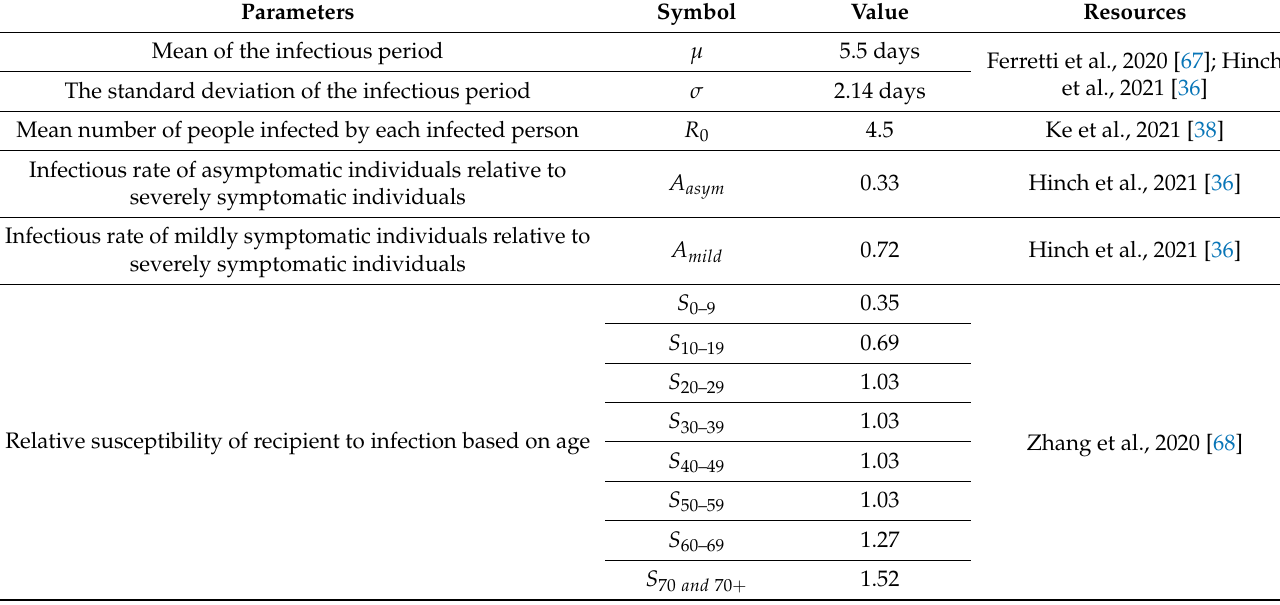
Table A4. The values of parameters considered in the calculation of the infection-transmission probability.